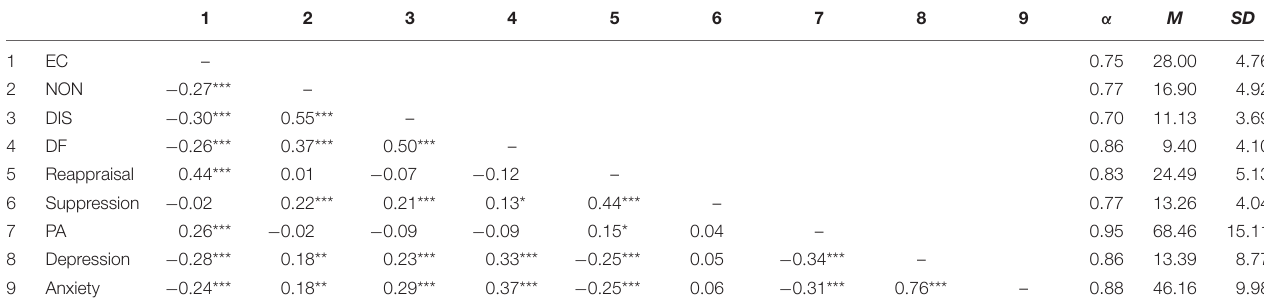
TABLE 1 | Correlations and reliability for study variables.